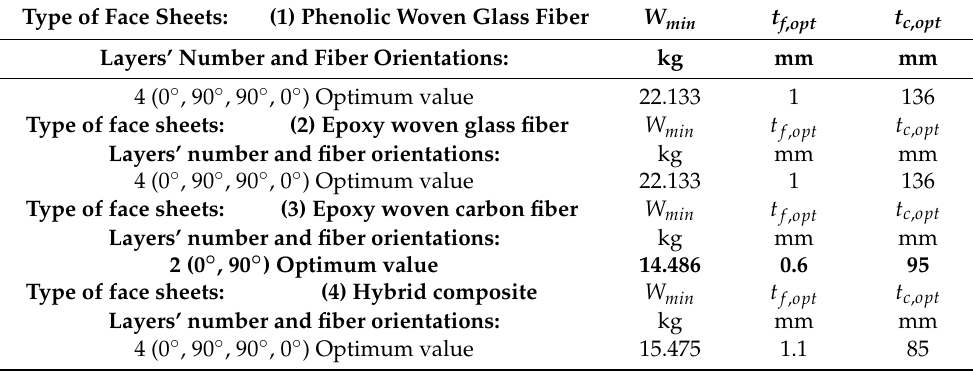
Table 5. Theoretical results for a sandwich plate of the helicopter floor consisting of composite hon- eycomb core (fiberglass/phenolic resin) and composite material face sheets with different numbers of layers and fiber orientations using the Excel Solver program (GRG Nonlinear Algorithm).